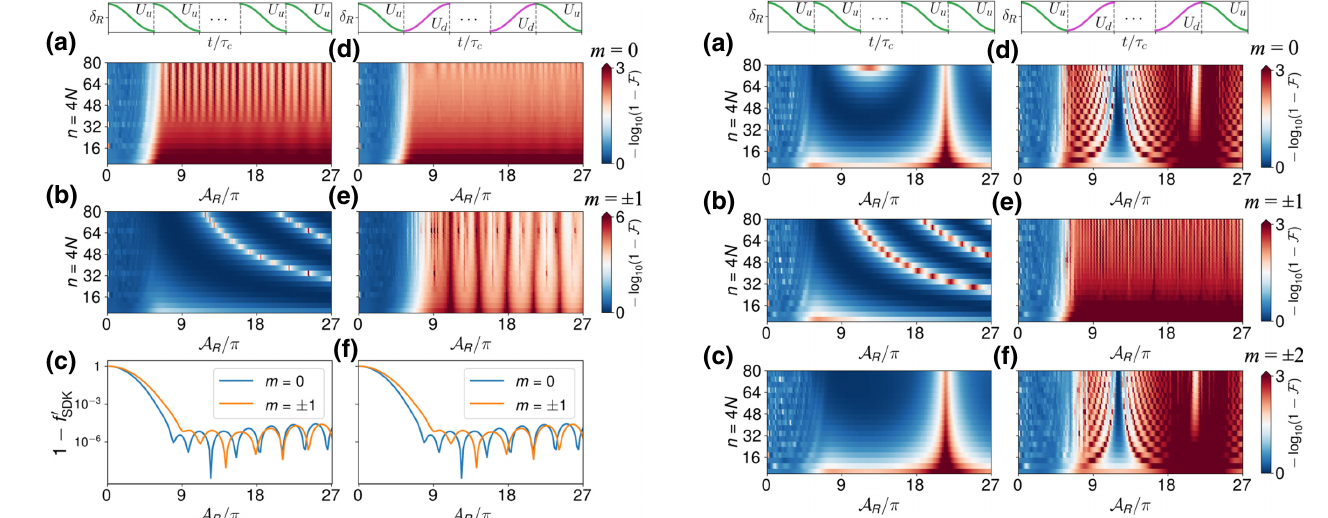
uddu , except for m